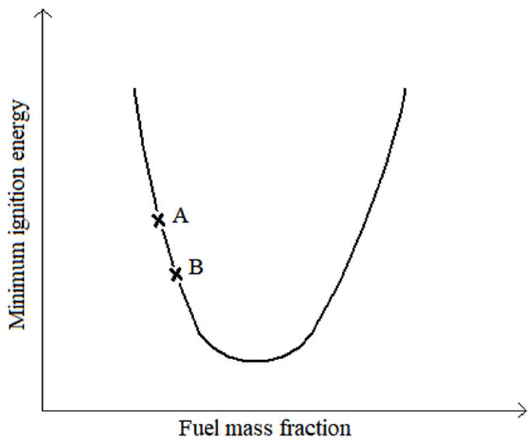
Figure 10. Generic explanation of the effect of batch size on ignition.